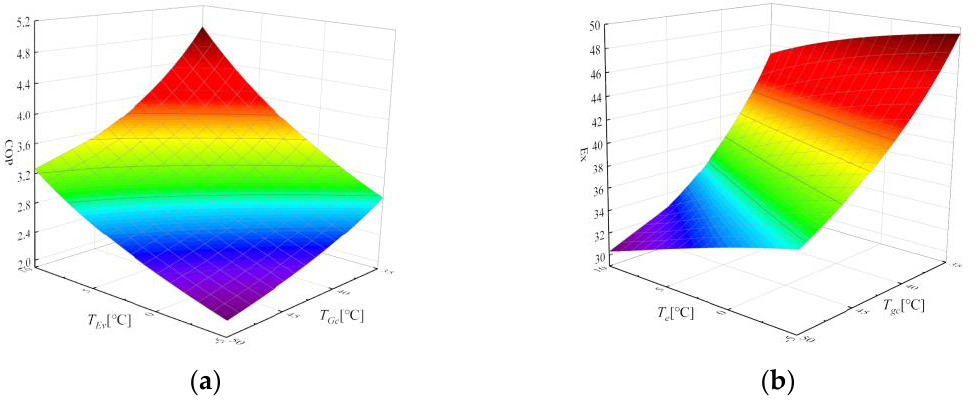
Figure 12. Three-dimensional plot of evaporation temperature and gas cooler outlet temperature on system performance: ( a ) Variations of COP; ( b ) Variations of the exergy efficiency.